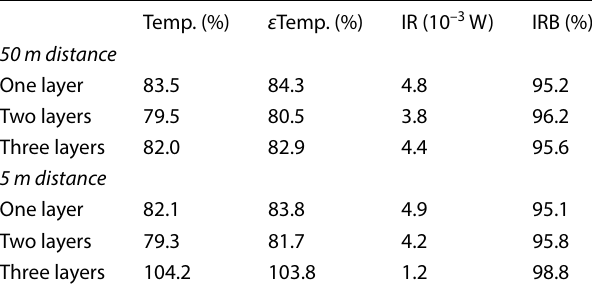
Table 3 Surface infrared measurements from one, two and three layers of two different rescue blankets (AMR: Austrian Mountain Rescue, ARC: Austrian Red Cross) covering a clothed body dressed in a fleece, plus down jacket, plus all-weather jacket (base) accord- ing to surface measurements made with a thermal camera at dis- tances of 50 m (temperature air: −1.3 to −5.3 °C; humidity: 62.3